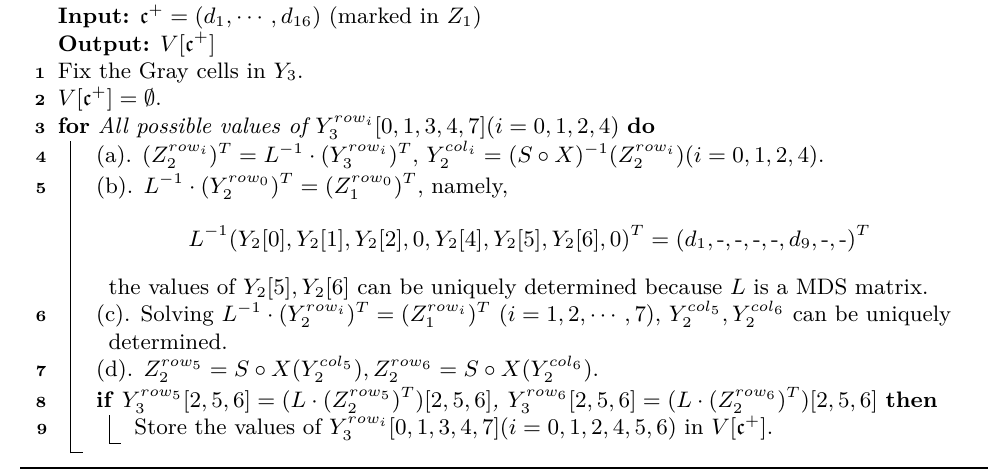
Algorithm 8: Compute the solution space of Blue cells in Figure